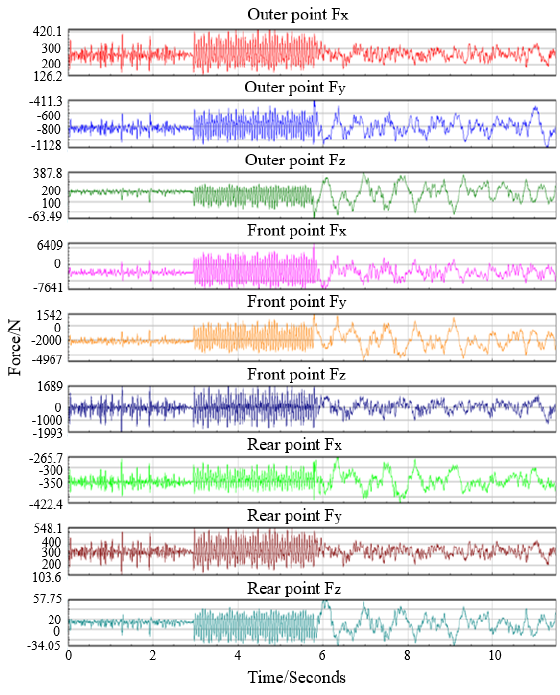
Figure 7. Load spectrum of control arm.